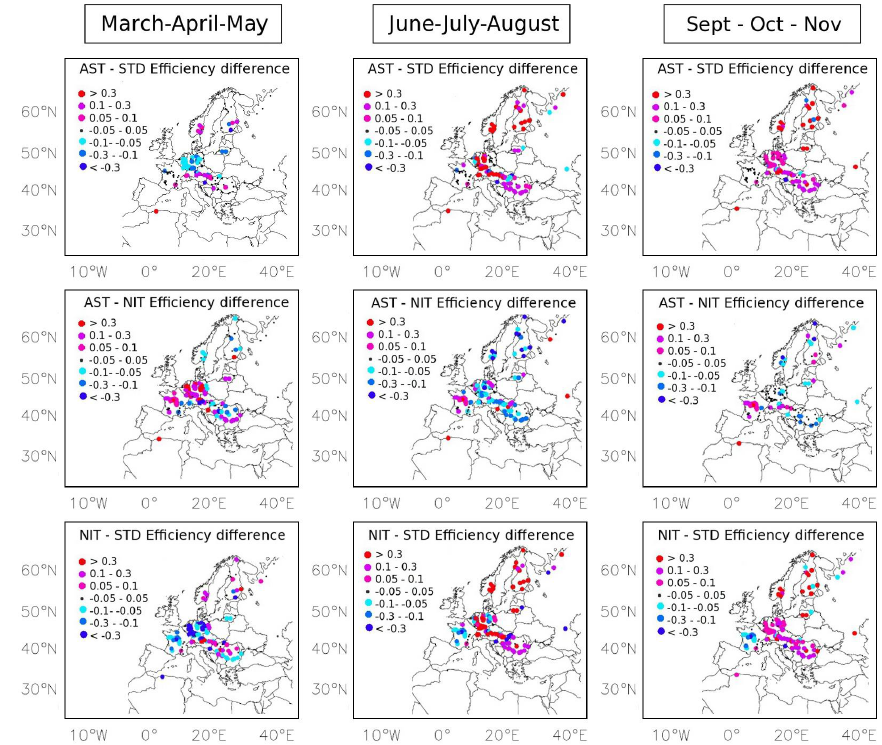
Fig. 9. Seasonal and model breakdown of river flow Eff differences over the CNF area, over the 1991–2008 period. From left to right: spring, summer and autumn. From top to bottom: AST minus STD, AST minus NIT, and NIT minus